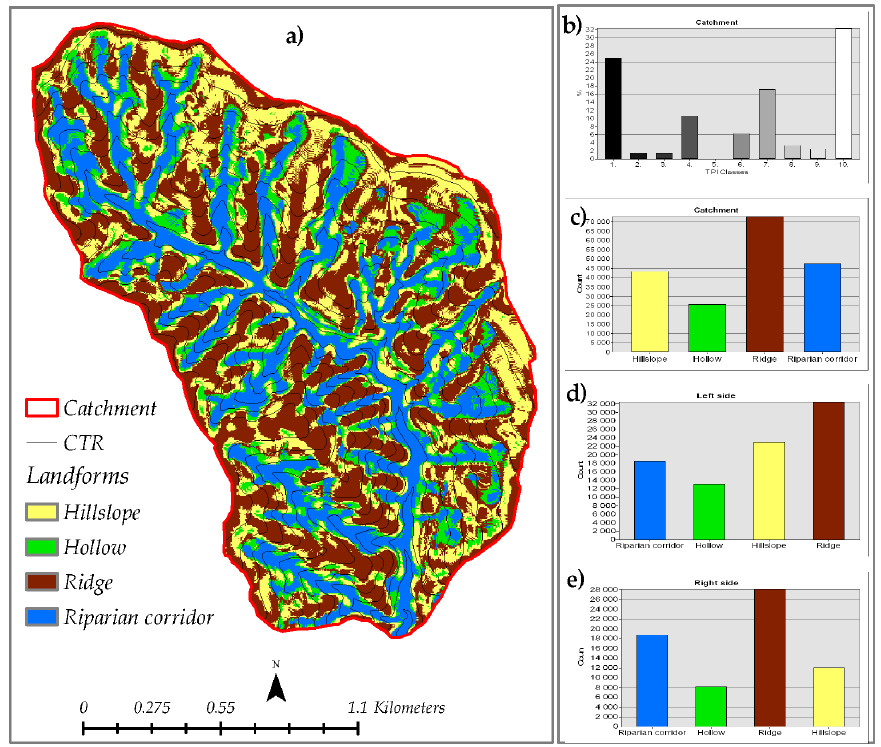
Figure 10. ( a )Topographic position Index (TPI) for the Ciciriello catchment; ( b ) frequency distribution of values on the unclassified map (1: incised stream; 2: midslope drainages, shallow valley; 3: upland drainages, headwater; 4: U-shaped valley; 5: plains; 6: open slopes, 7: upper slopes, mesas; 8: local ridges/hills in valleys; 9: midslope ridges, small hills in plains; 10: mountain tops, high ridges); ( c ) frequency distribution on the classified TPI map on the catchment, on the left ( d ) and right side of the catchment ( e ).